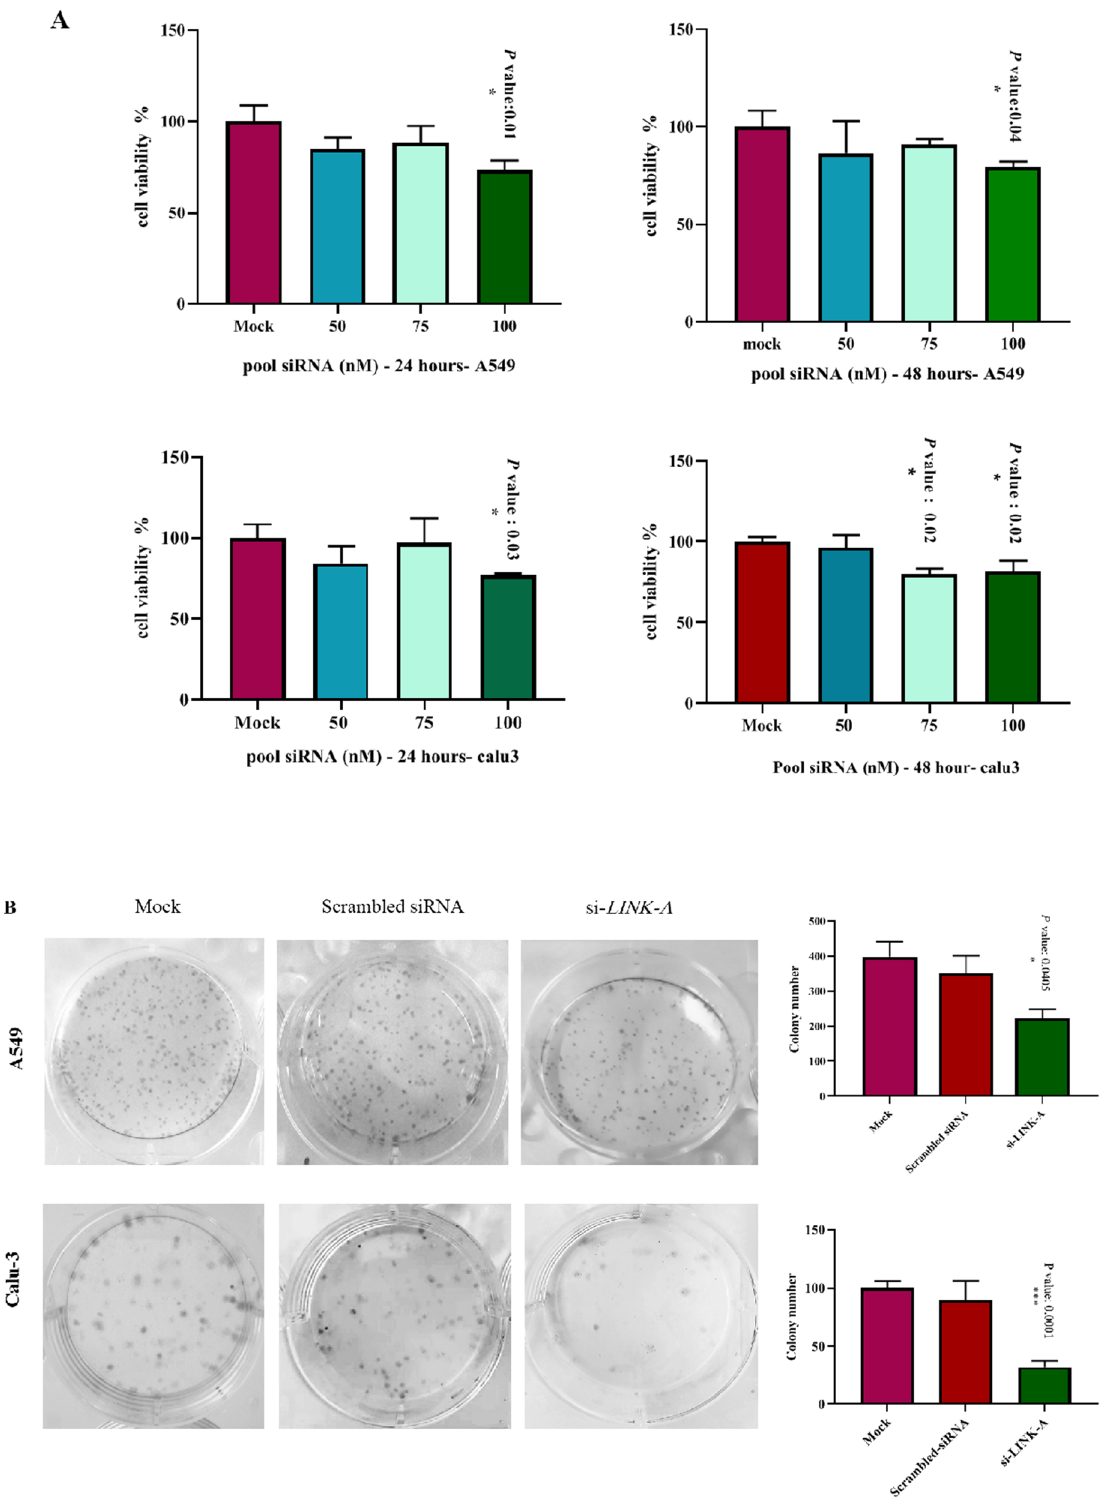
Figure 2. LINK-A downregulation impacts on cell viability and proliferation. ( A ) The Graphs of MTT assays in 24 and 48 hours after transfection in A549 and Calu-3 cell lines, the error bars show mean ± SD (* P value < 0.05, *** P value < 0.001, two-tailed t test). ( B ) Colony formation assay images represent reduced colony-forming ability in LINK-A silenced cells compared to control groups. The error bar indicates the mean ± SD. (* P value < 0.05, two-tailed t